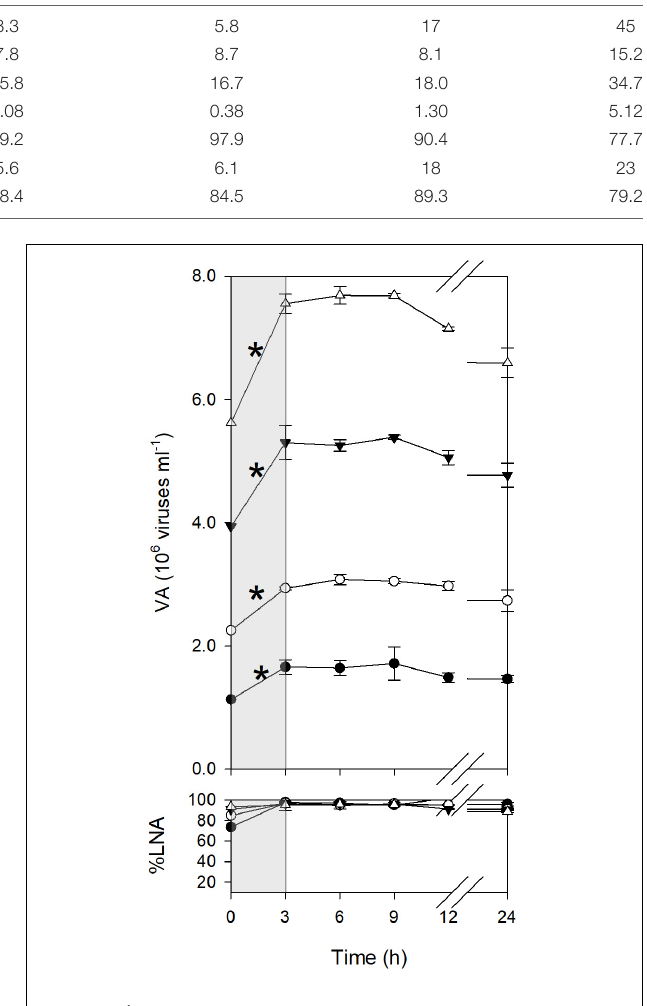
FIGURE 1 | Dynamics of viruses during incubation (January experiment). The bottom panel shows the percentage of LNA bacteria to total bacterial abundance. Open triangles, 1 dilution; closed triangles, 0.7 dilution; open circles, 0.4 dilution; closed circles, 0.2 dilution. Errors are the standard deviations of the measurements using triplicate bottles ( n = 3). The gray shading highlights a time interval with a significant increase in viral abundance, as indicated by asterisks. The significance of the difference between T0 and T3 was tested using the 95% confidence interval (see section “Materials and